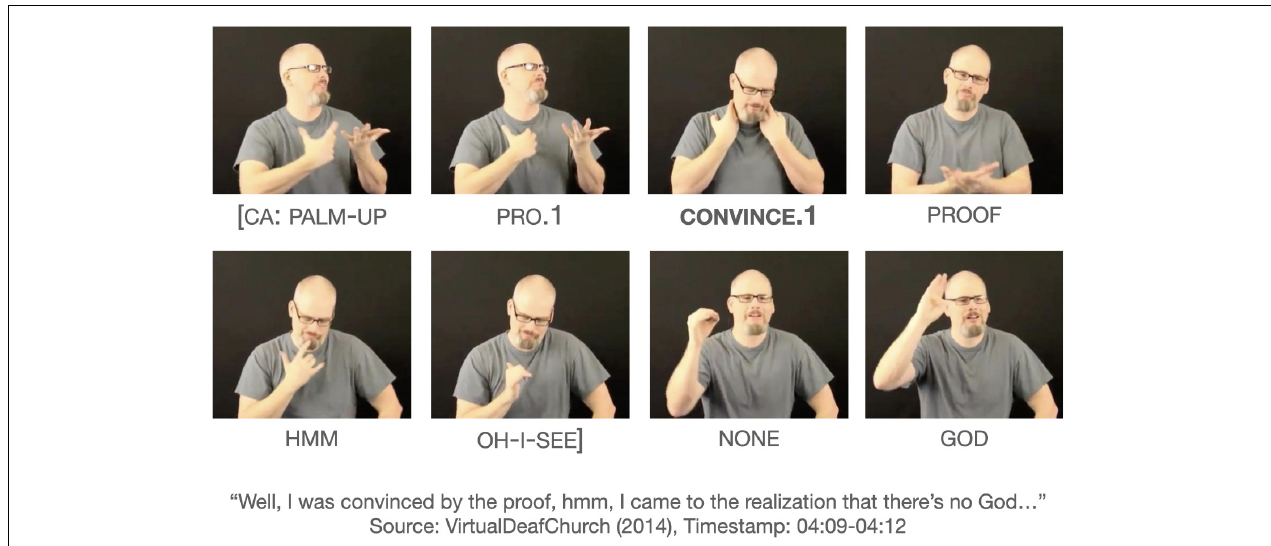
FIGURE 5 | An example of in CONVINCE .1 in an indefinite construction. Images produced with permission, source information available in the Supplementary Material .